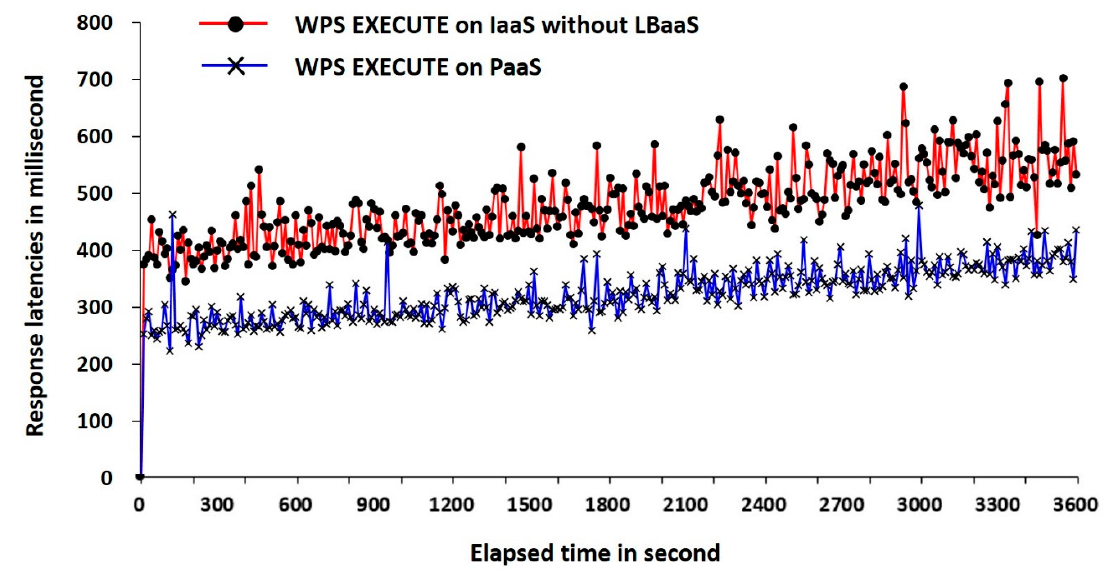
Figure 4. Performance test result for OGC WPS 2, executing an operation, with an edge detection algorithm, on PaaS and IaaS without LBaaS: a case of 300 threads for 3600 s.